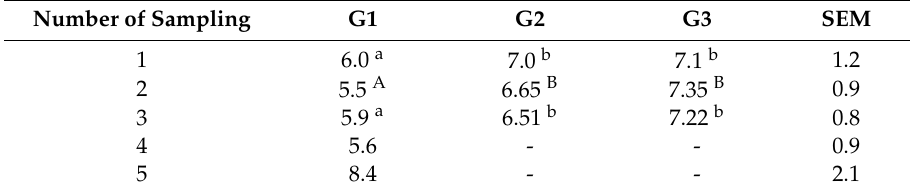
Table 4. Changes in fat (%) content in sheep’s milk from the Group 1 (lambing in February–milked from April to August, Group 2 (lambing in June–milked from August to October), Group 3 (lambing in June–milked from August to November and melatonin-treated before 6 weeks parturition).